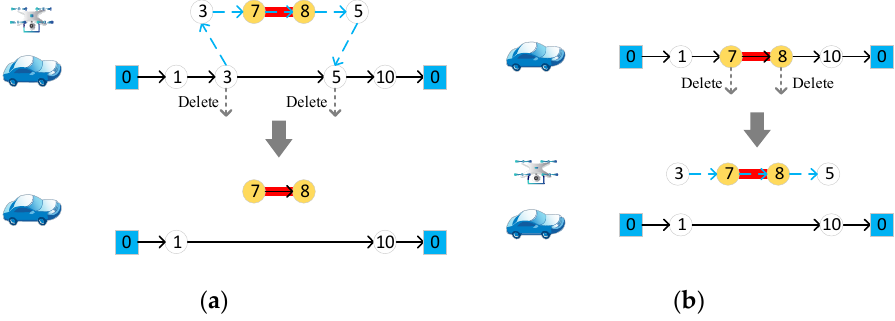
Figure 10. Change the assignment object of the target edge. ( a ) Drone to vehicle; ( b ) vehicle to drone. Different numbers in the figure represent different nodes of the road network.